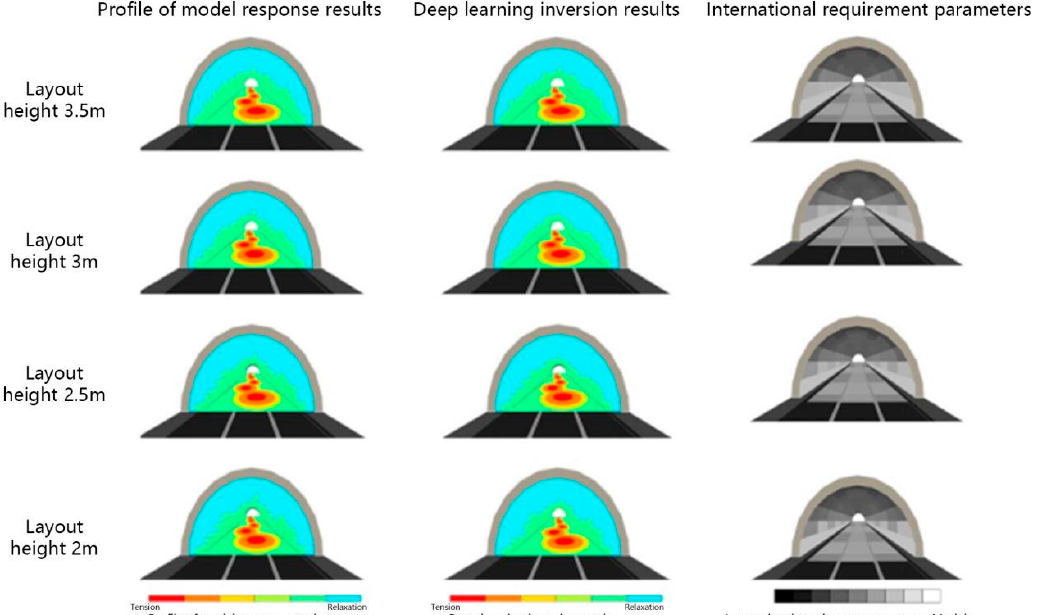
Figure 6. Sensitivity analysis of luminaire layout.